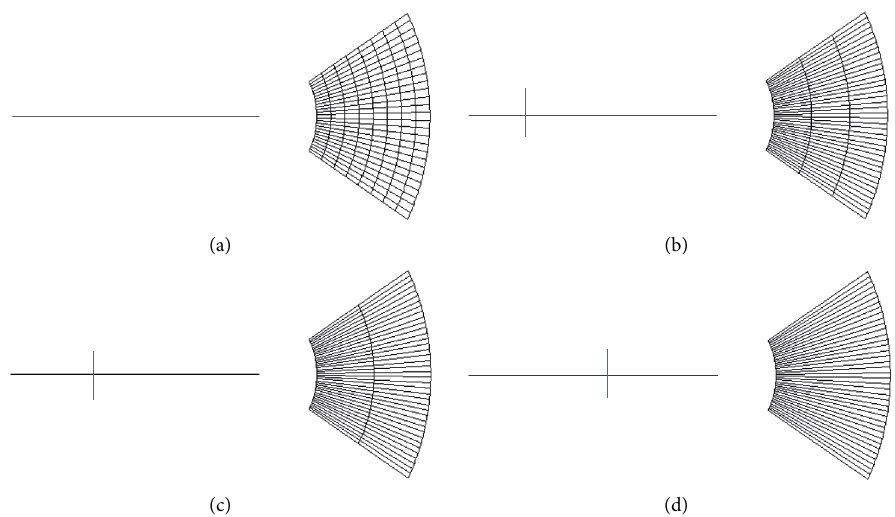
Figure 7: (a) No consolidation center. (b) MaxiMin objective function. (c) MaxiMax objective function. (d) MinVKT objective